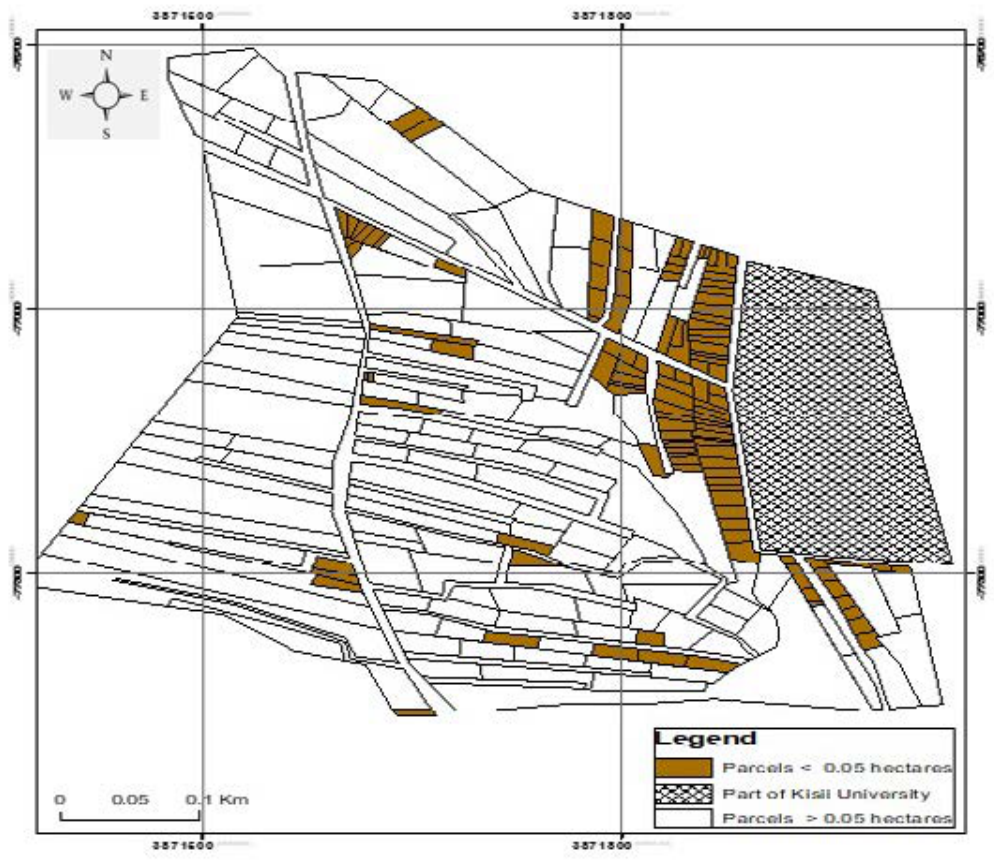
Fig. 7: Noncomplying land subdivisions in 2020 Table 9: Case by case grouping of observed compliance with BCR Table 9: Case by case grouping of observed compliance with